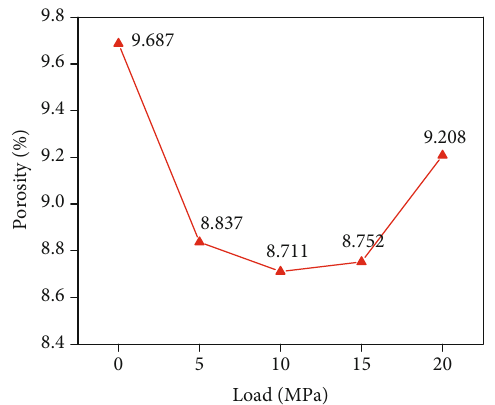
Figure 5: The porosity of sandstone varies with di ff erent load